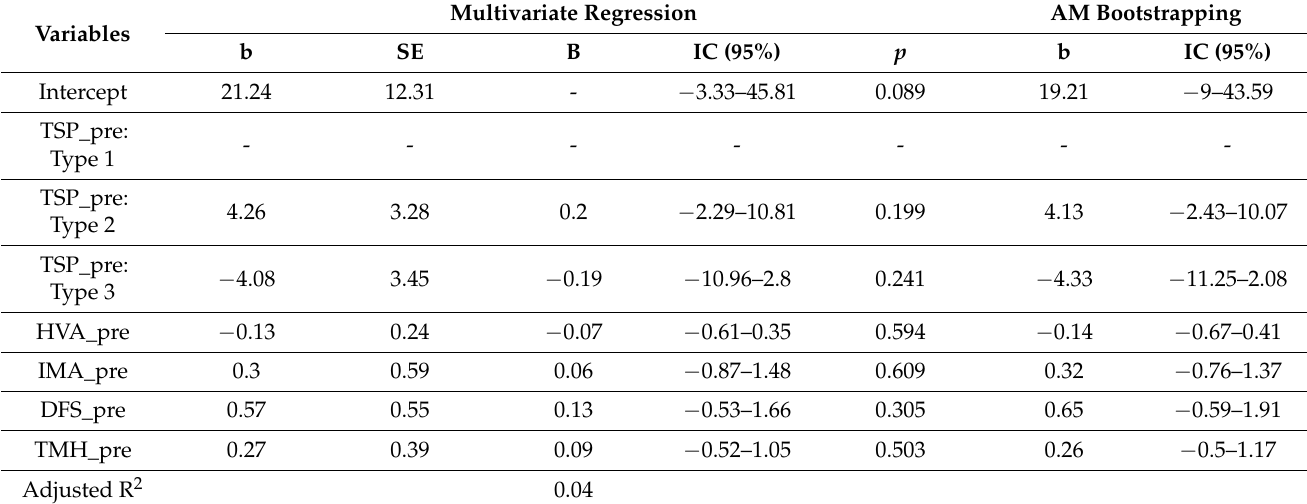
Table 6. Multivariate regression of preoperative MOXFQ values with the preoperative radiological measures. Pre: Preoperative values. DFS: Distance of the fibular sesamoid bone to the second metatarsal axis. TMH: Translation of the first distal metatarsal head. HVA: Hallux valgus angle. IMA: I–II intermetatarsal angle. TSP : Tibial Sesamoid Position. MOXFQ: Manchester-Oxford